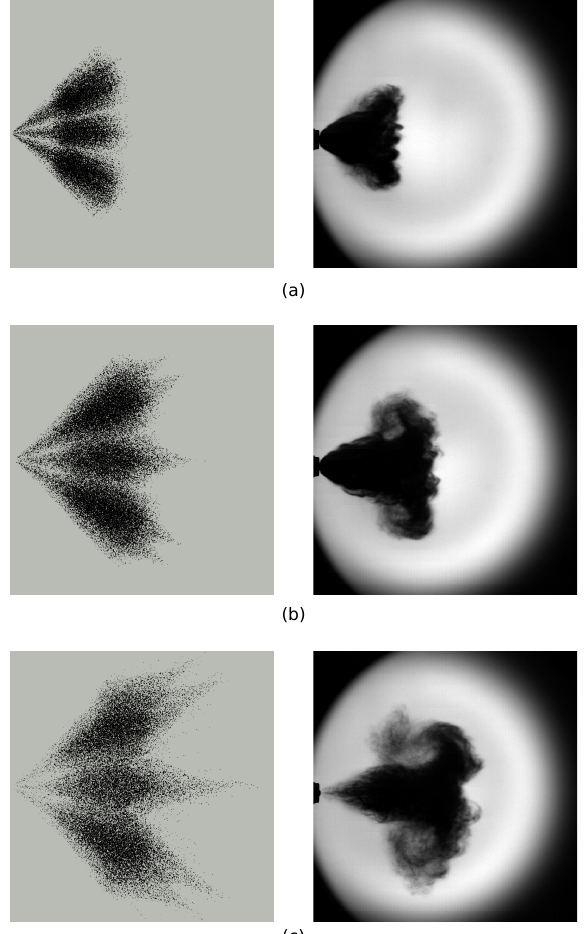
Figure 17. Numerical ( left ) vs. CMT experimental ( right ) liquid morphology images for the G2 cold condition for n–pentane. ( a ) at 0.3ms, ( b ) at 0.6ms and ( c ) at 0.9ms after